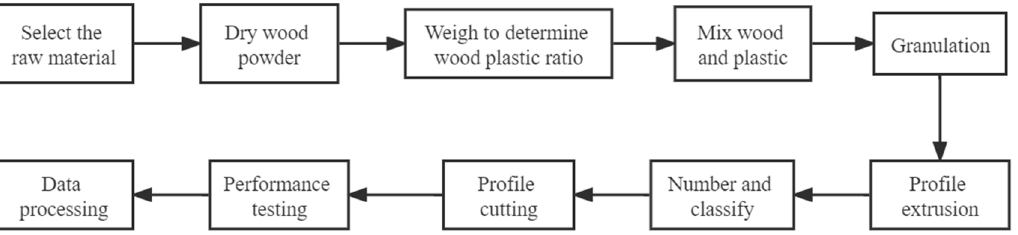
Figure 2. Main process of the test.